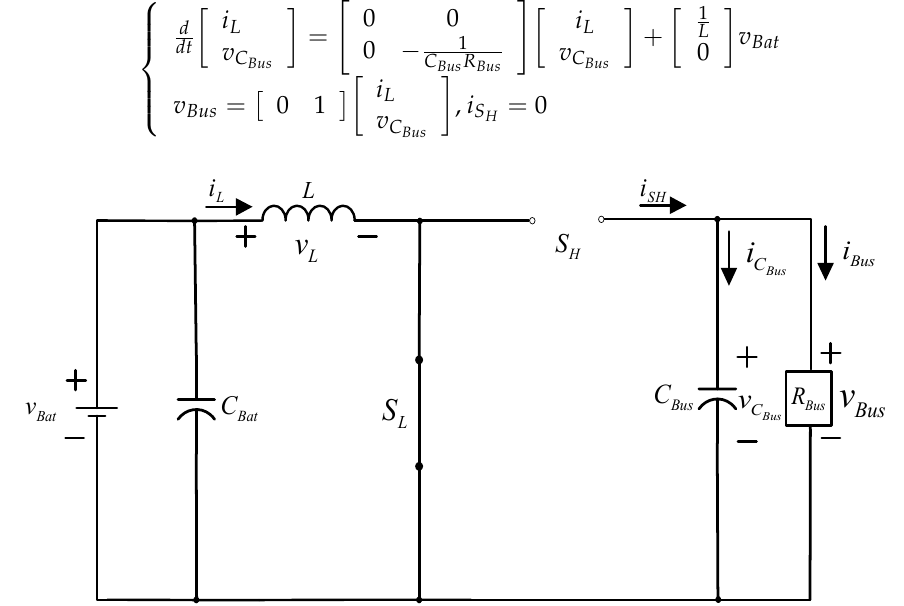
Figure 4. The equivalent circuit of the bidirectional buck–boost converter when the low-voltage side switch S L is conducting and the high-voltage side switch S H is in a cut-off state.